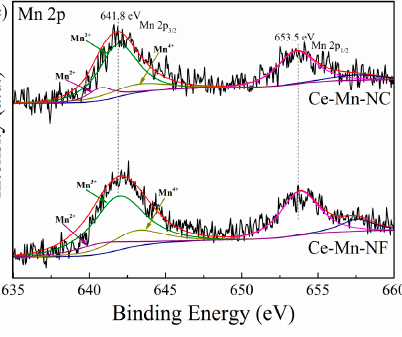
Figure 4. XPS spectra of various catalysts over the spectral regions of Ce 3d ( a ), O 1s ( b ) and Mn 2p ( c ).